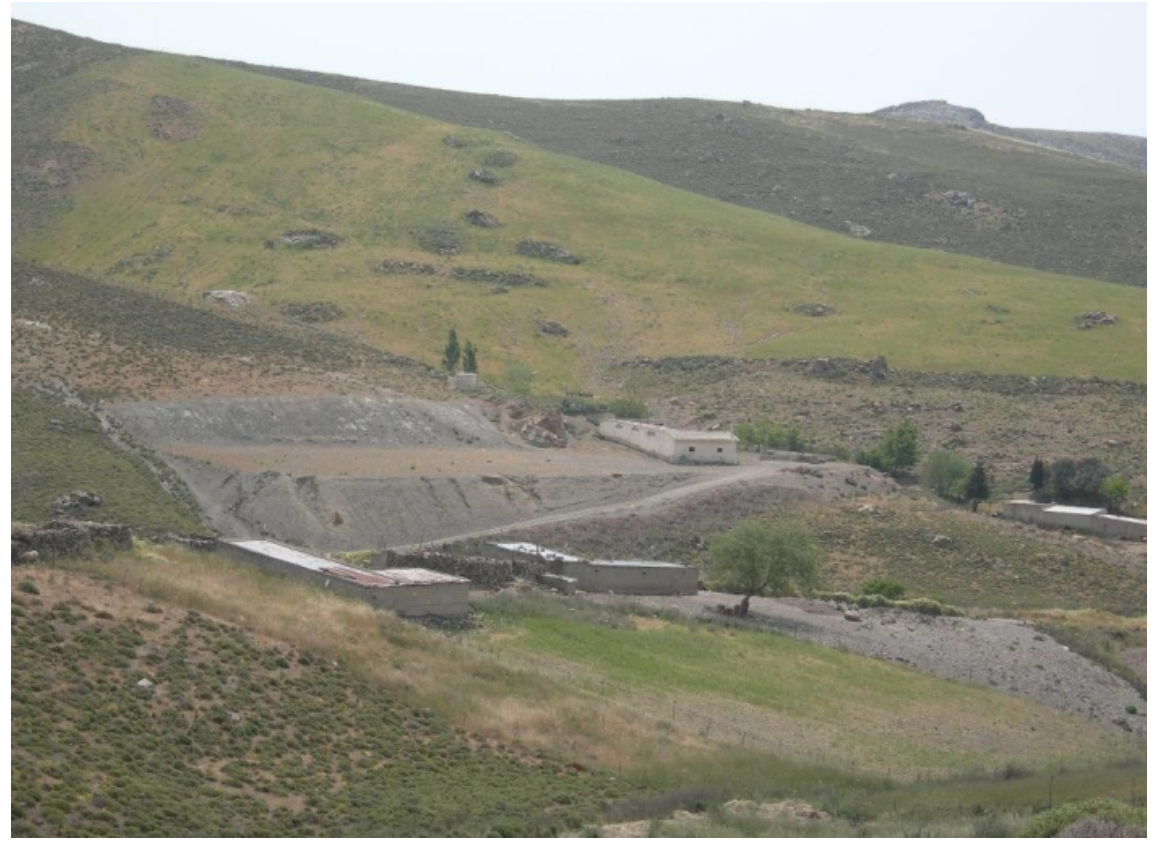
Figure 10. Land-use changes suspected to be provoked by LFA subsidies (Asterousia). Dark green areas are rangeland covered with phrygana. The light green areas, above and under the shed in the picture, are rangeland recently converted to barley meadows. Plough lines along the slope and starting gullies linked to this land-use change are visible in the